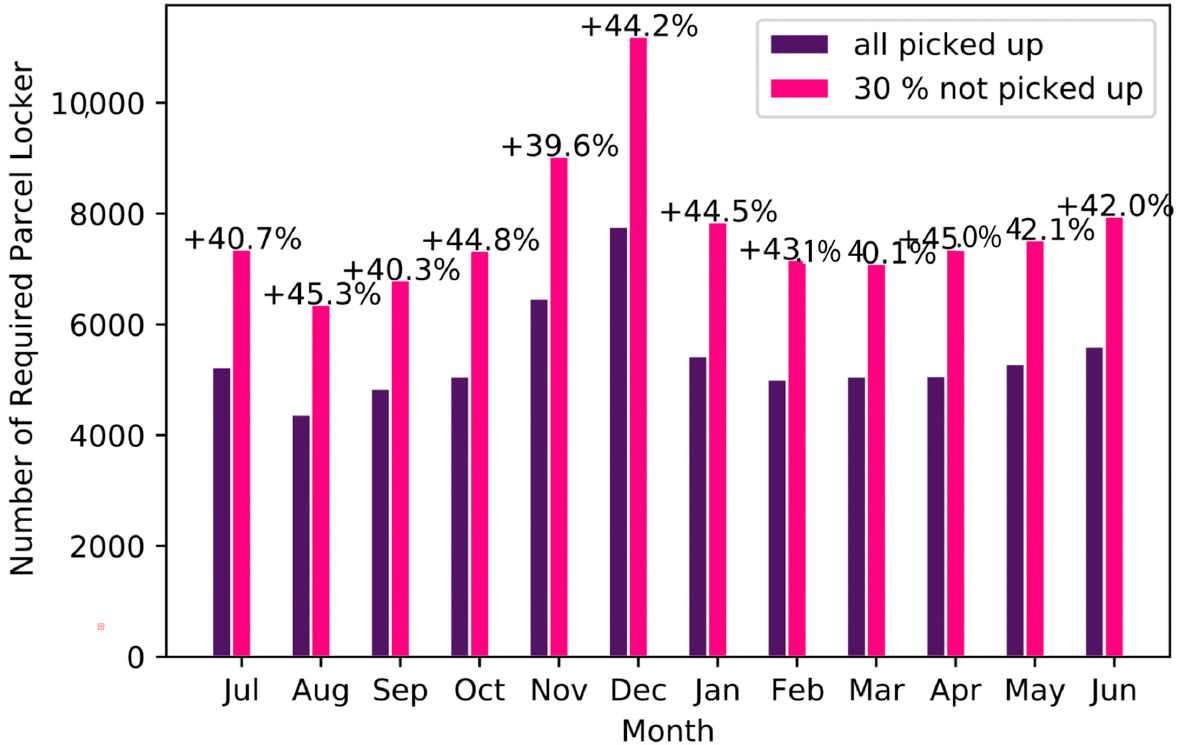
Figure 5. Comparison of the mean number of locker spaces per month between all parcels picked up and 30% of parcels not picked up (Density 1.0).